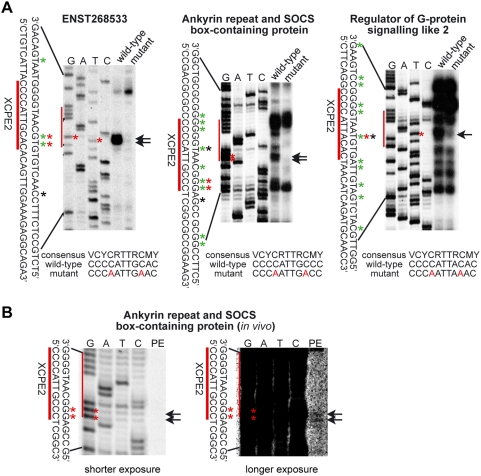
XCPE2 drives transcription from human promoters.(A) In vitro transcription analyses of wild-type and XCPE2-mutated promoter templates. Sequence ladders were made using the same sets of templates and primers as those for the primer extension analyses. Arrows and red asterisks (*) show the TSSs at the position expected to be driven by XCPE2. Green asterisks show the nucleotide positions of other start sites detected in our in vitro transcription assays. Black asterisks show the nucleotide positions of start sites recorded in the DBTSS database. (B) Primer extension analysis of Ankyrin repeat and SOCS box-containing protein mRNA produced in transfectecd HepG2 cells, showing that the same TSSs driven by XCPE2 as in vitro transcription assays were detected. Arrows and red asterisks show the TSSs driven by XCPE2.